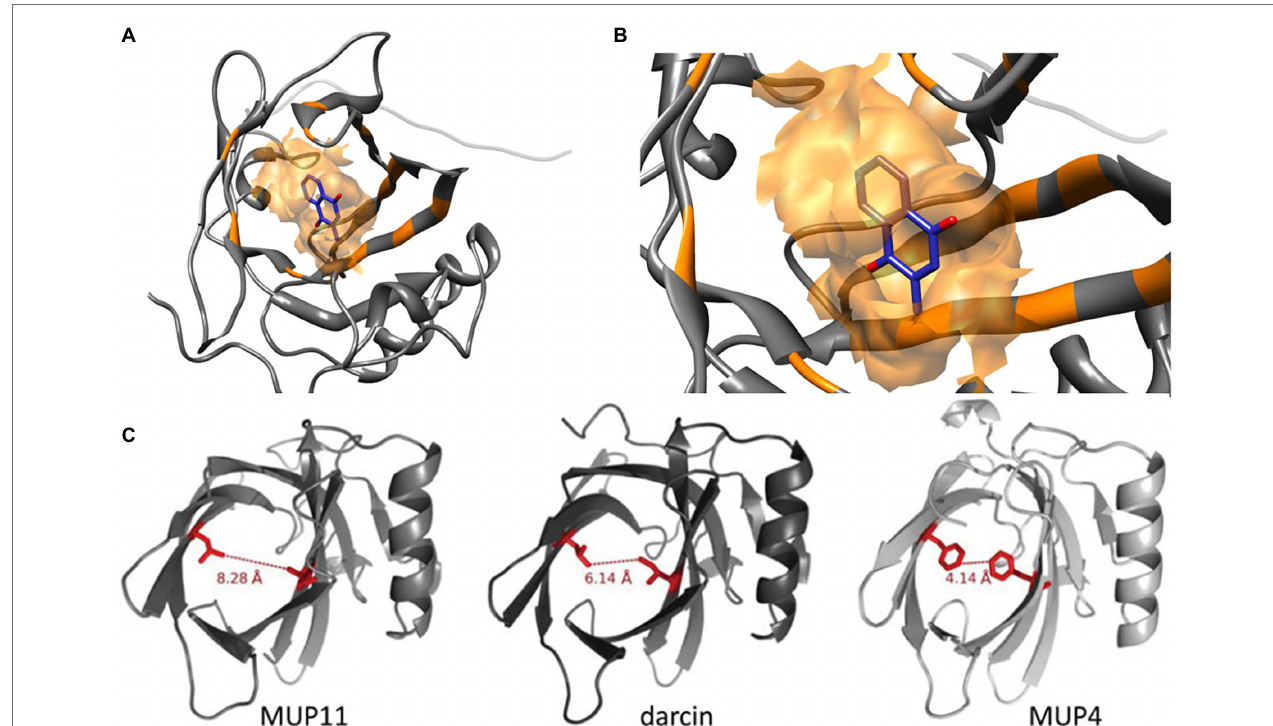
FIGURE 1 | Molecular Structures of MUP Proteins and Pheromone Ligands. MUPs are low molecular weight (18–40 kDa) proteins (162 amino acids) in the structural family of lipocalins, which have a barrel-shaped tertiary structure used for binding and transporting small molecules (Diez-Hermano et al., 2021). (A) The models shown here illustrate how each MUP contains a cavity that binds small hydrophobic ligands (B) , for example, menadione from Ricatti et al. (2019). These small molecules include male pheromones, such as 2-s-butyl-4,5-dihydrothiazole, 3,4-dehydro-exobrevicomin, and 6-hydroxy-6-methyl-3-heptanone (Böcskei et al., 1992; Žídek et al., 1999; Timm et al., 2001; Mucignat-Caretta and Caretta, 2014). (C) The binding cavities and interatomic distances between two similar residues are shown in red for a central MUP proteoform (MUP11), and the peripheral proteoforms of darcin and MUP4. MUP20 shows binding specificity for the pheromone 2-s-butyl-4,5-dihydrothiazole (SBT). Figure used with permission from Phelan et al.